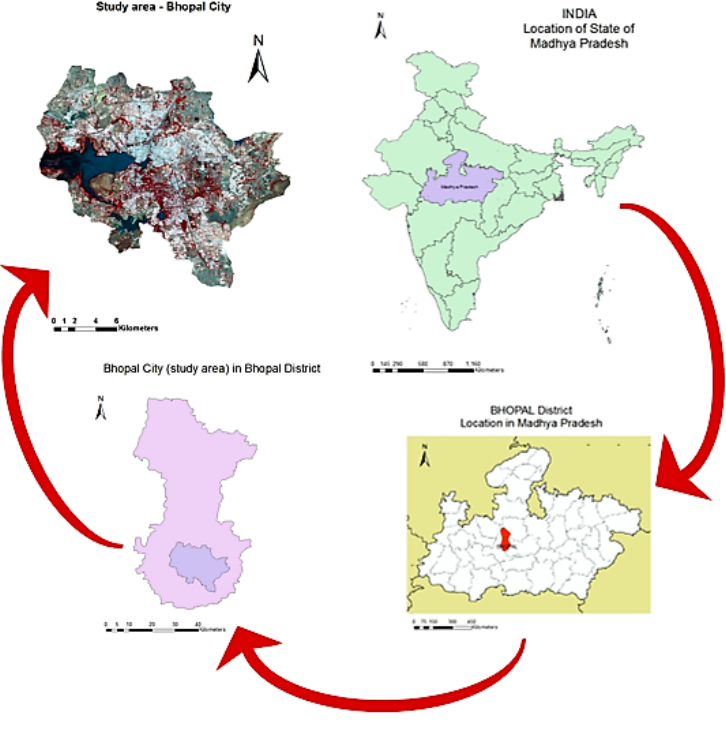
Fig. 1: Location of the study area